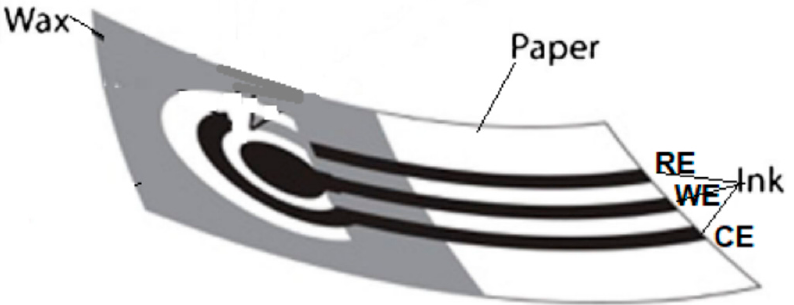
Figure 4. Typical screen-printed electrode (SPE) of e-PADs obtained with the screen-printed tech- nique.